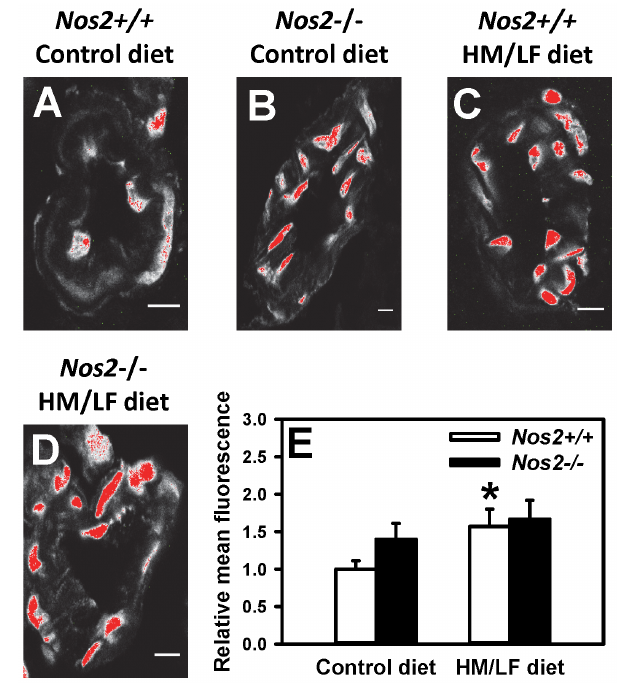
Figure 4. Laser-scanning confocal micrographs of cerebral arterioles stained with DHE. (A) Nos2 + / + mice fed the control diet. (B) Nos2 2 / 2 mice fed the control diet. (C) Nos2 + / + mice fed the HM/LF diet. (D) Nos2 2 / 2 mice fed the HM/LF diet. (E) Quantification of DHE fluorescence using Image J. Images are representative of 5 separate experiments. Scale bar =10 m